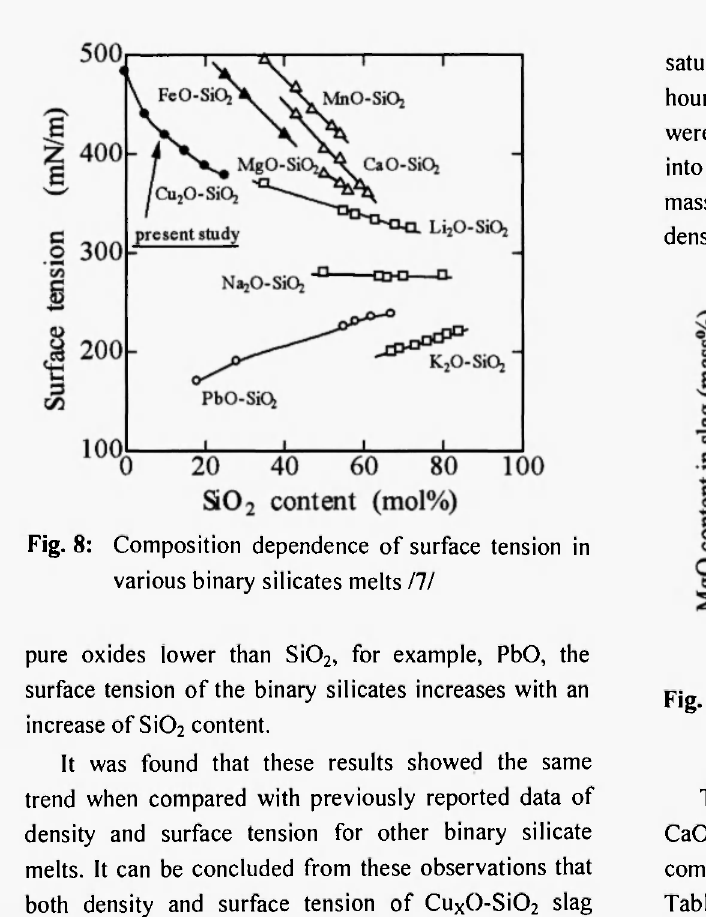
Fig. 9: Dissolved MgO content in Cu x O-CaO slag. The slag samples were analyzed for Cu 2 0, CuO, CaO and MgO after experiments. The chemical compositions before and after experiments are shown in Table 2. The ratios of Cu 2 0 and CuO were determined in the same manner as before. CuO content in the slag was not greatly changed but Cu 2 0 decreased with increasing CaO content in the slag. This means that the ratio of Cu + /Cu 2+ slightly decreased with an increase of basicity of the slag if basicity of CaO is stronger than Cu x O. It is quite different in the case of the Cu x 0-Si0 2 system. This behavior might be explained by a Cu + /Cu 2+ redox reaction in a Cu x O-CaO melt shown in equation